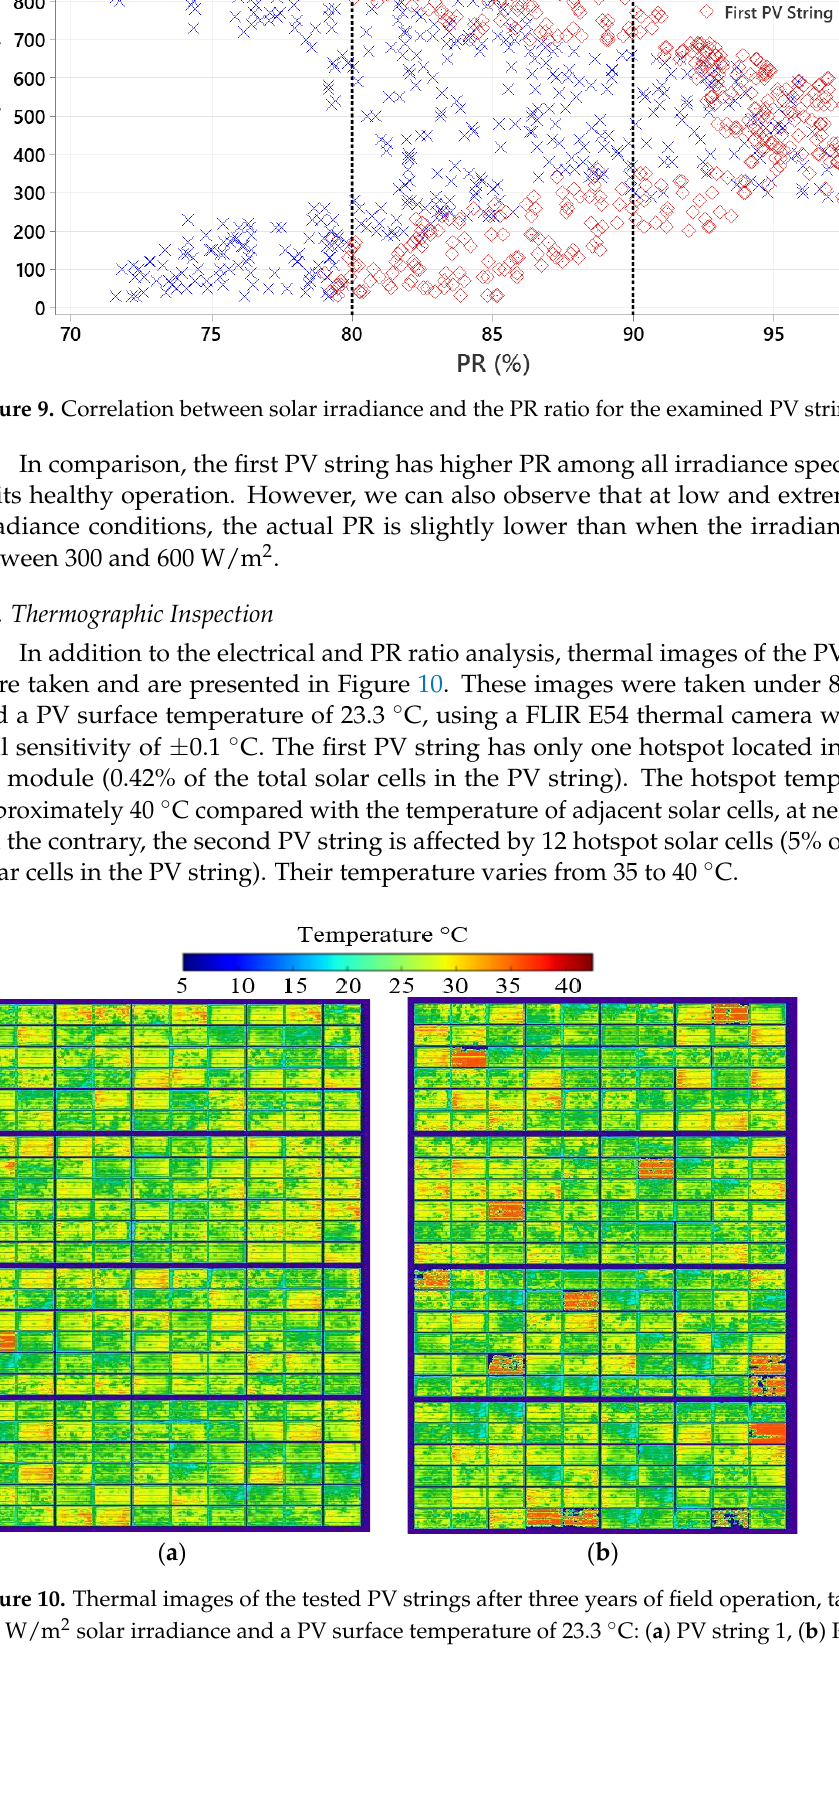
Figure 10. Thermal images of the tested PV strings after three years of field operation, taken under 830 W/m 2 solar irradiance and a PV surface temperature of 23.3 °C: ( a ) PV string 1, ( b ) PV string 2.